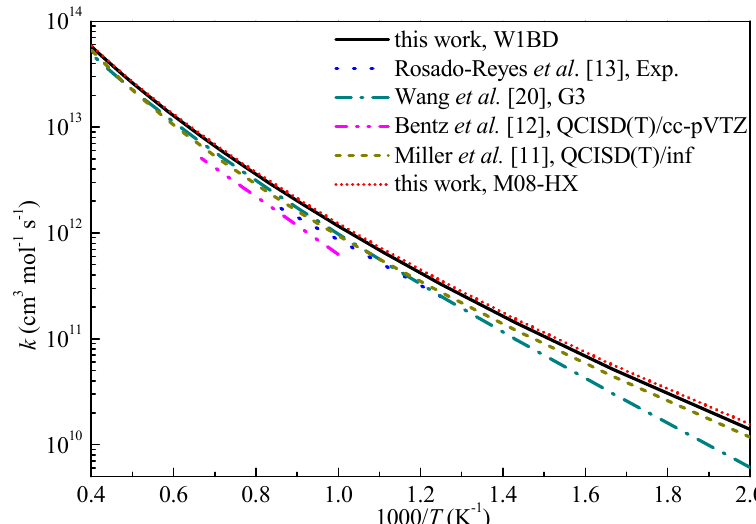
Figure 6. Computed rate constants for the H-abstraction reaction of propyne with H at propargyl site.